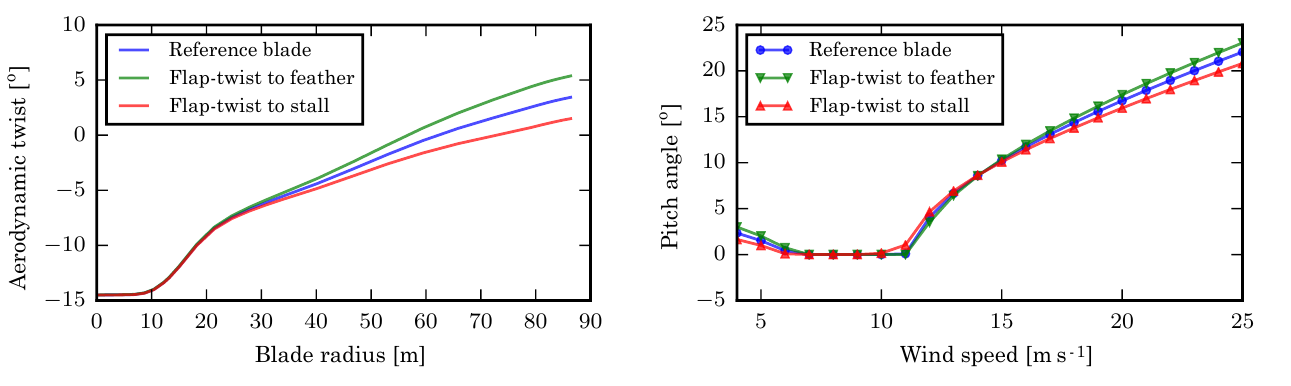
Figure 3. Aerodynamic twist along the blade for the reference and flap–twist to feather and stall coupled blades with coupling coeffi- cients γ y = ± 0 . 1 constant along the blades.